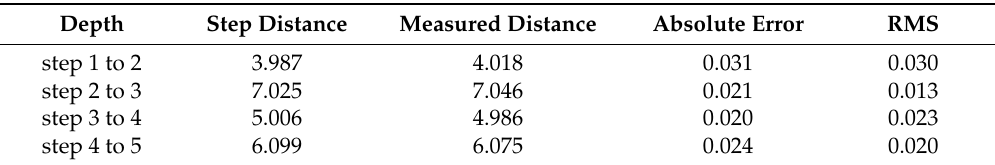
Figure 8. Illustration of the designed step-shaped mirror with step numbers and measured depths. ( a ) The designed steps; ( b ) image of the fringe pattern reflected by the stepped surface; ( c ) shaded display of the measured depth; ( d ) the profile of the measured mirror step. The X - and Y -axes represent the pixel positions. Table 2. Experimental results on the mirror step artifact (Unit: mm). Table 2. Experimental results on the mirror step artifact (Unit: